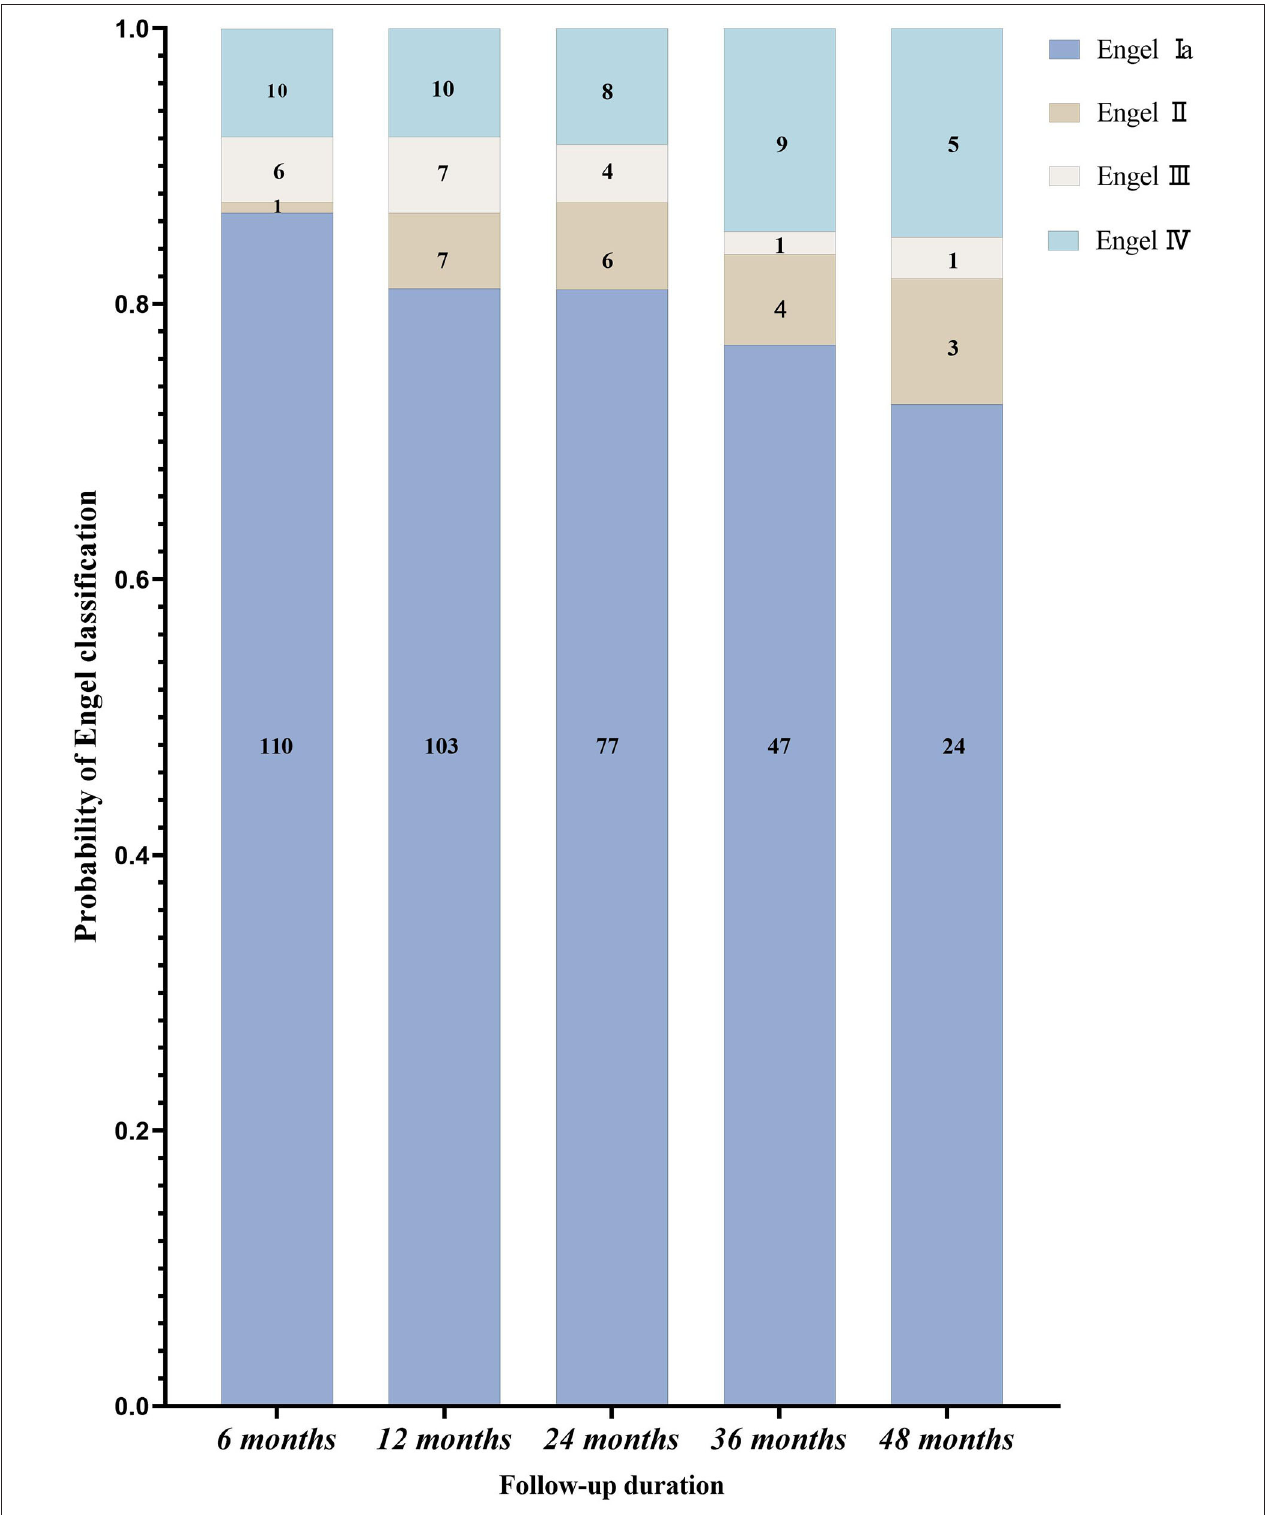
FIGURE 4 | The postoperative follow-up of patients with epileptic spasms according to the Engel classification ( n = 127).